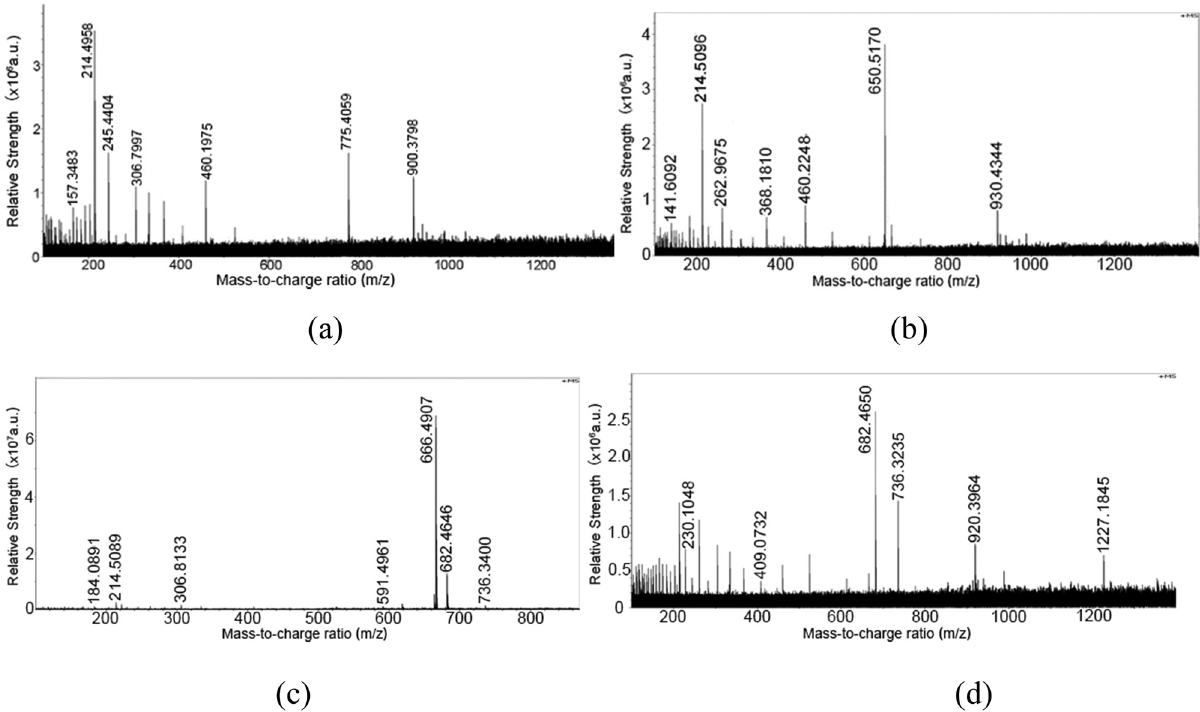
Figure 4: The spectrum of GC in the presence of ionization reagents: ( a ) Se + , ( b ) Li + , ( c ) Na + ( C ) , and ( d ) K + .